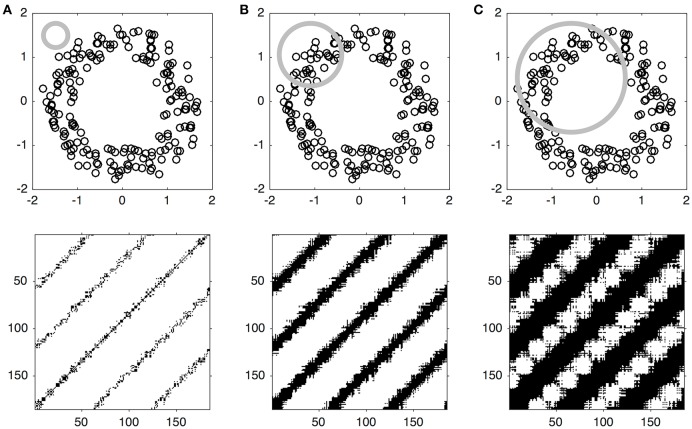
Illustration of the effect of the threshold parameter on the percentage of recurrence points in an RP. The upper panels (A–C) show the same phase-spaces as in Figure 1, but with an application of increasingly larger threshold, within which points in phase-space are counted as being recurrent, illustrated by a gray circle. The lower panels (A–C) show that the corresponding RP yield increasingly higher percentages of recurrence points, evident by the increasing thickness of the diagonal line patterns on the plots.